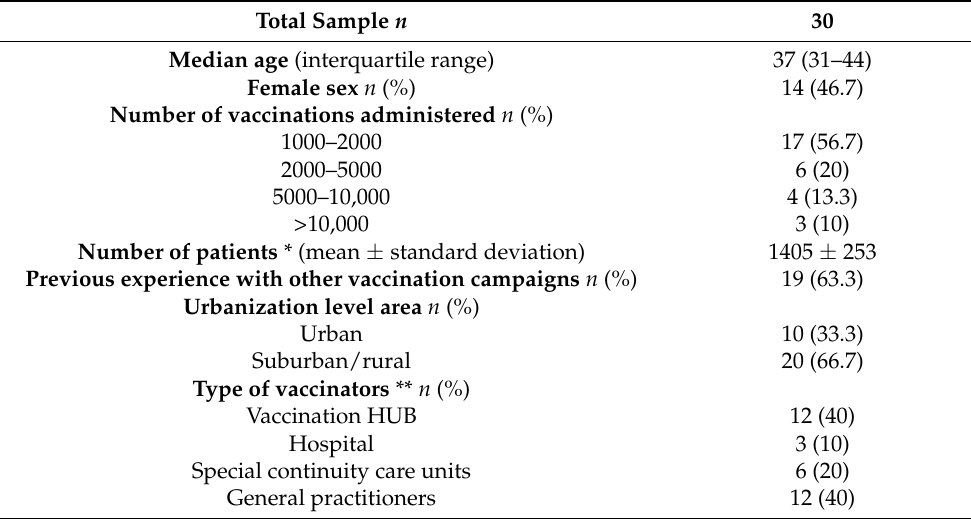
Table 1. Study sample